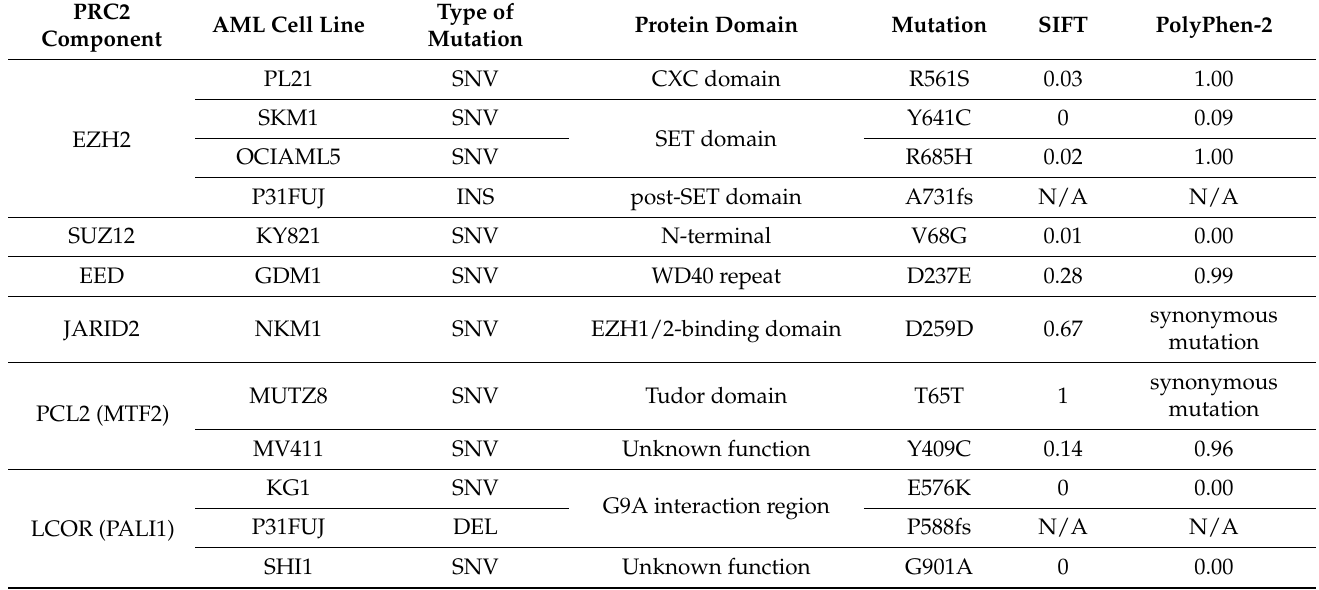
Table 2. PRC2 mutations in AML cell lines. Information was extracted from the DepMap portal (https://depmap.org/portal, accessed on 6th July 2022). The structural domain of the corresponding protein is indicated along with the SIFT [46] and PolyPhen-2 [47] scores to indicate the predicted functional consequence. A low SIFT score and a high PolyPhen-2 score indicates a damaging mutation. N/A: Prediction of functional consequence was not possible for some insertion and deletion